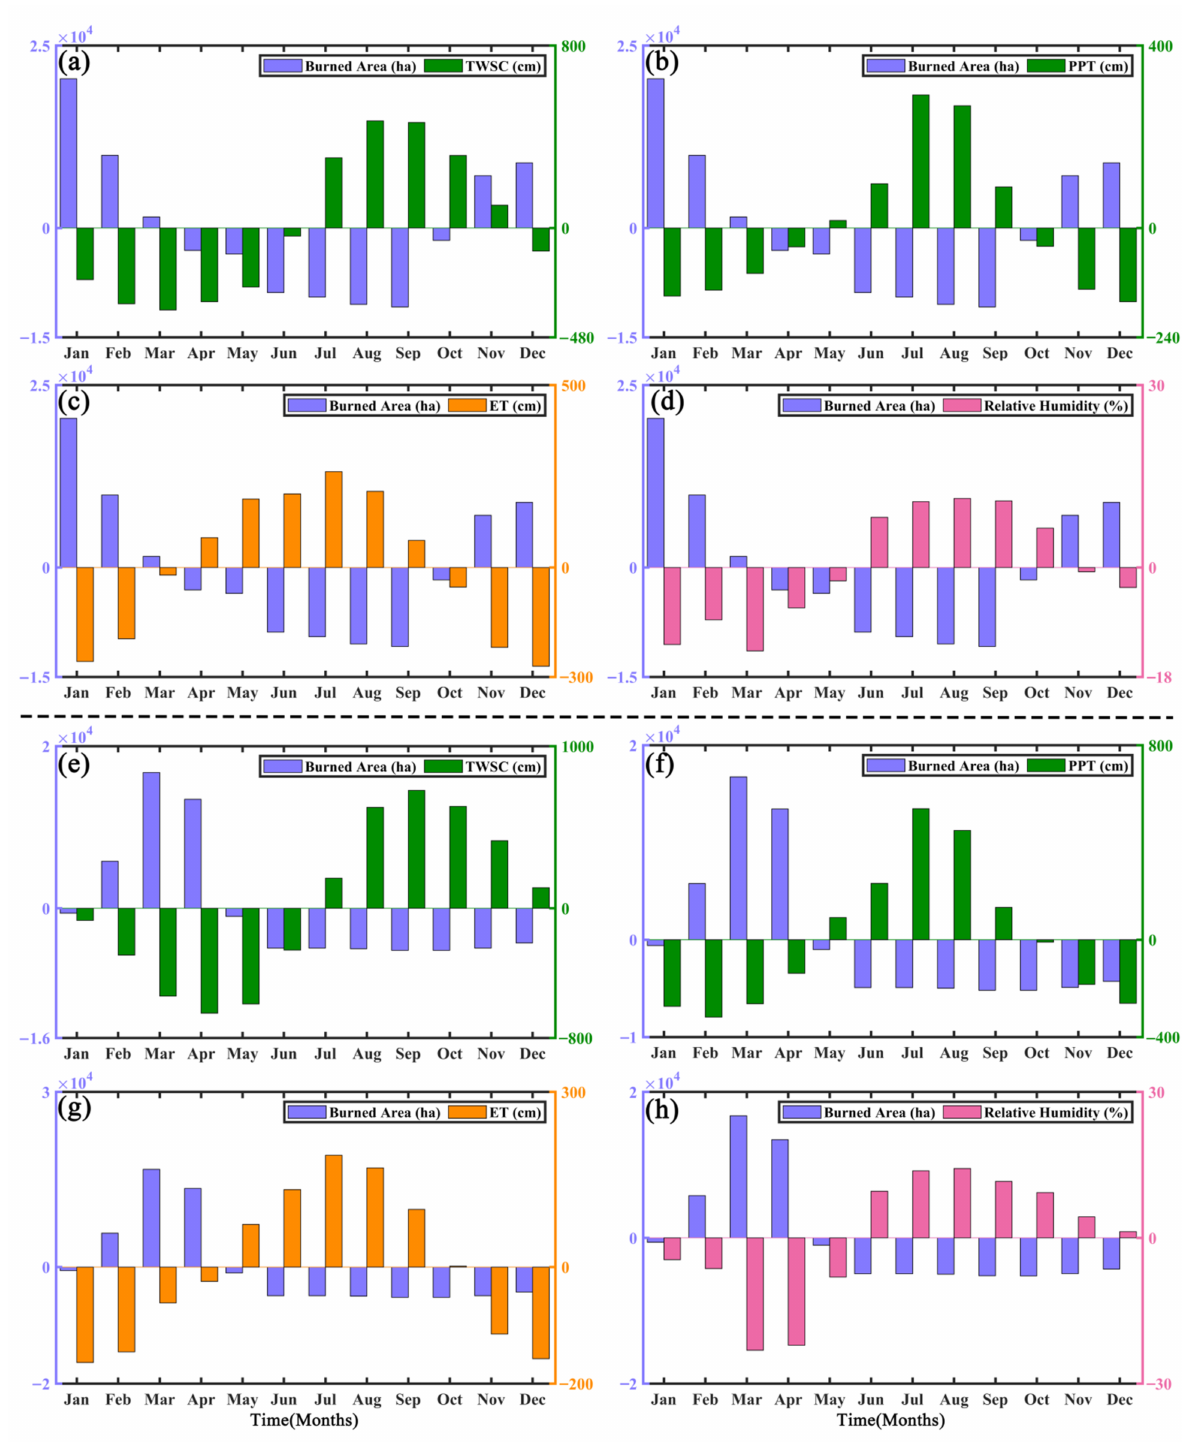
Figure 9. The seasonal variation of burned area (ha), TWSC (cm), PPT (cm), ET (cm) and relative humidity (%) from 2003 to 2016 in the region NW ( a – d ) and S ( e – h ). The seasonal variation was obtained by subtracting the average of the corresponding months for all years from the data for each month. The four figures above the blank dotted line are for region NW, and the four ones below are for region